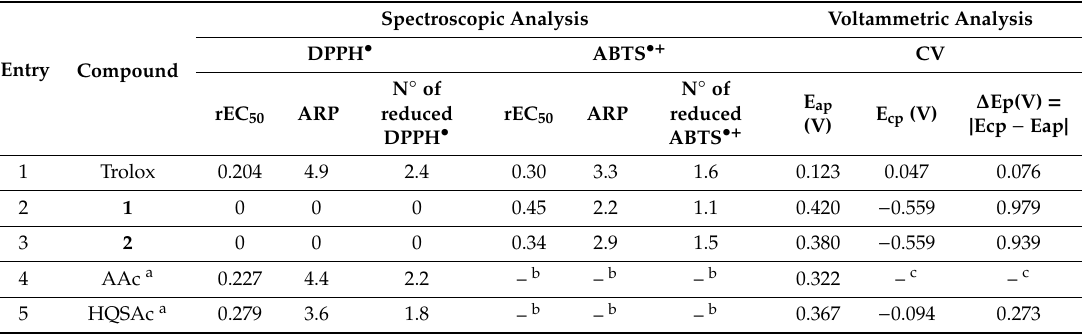
Table 3. Spectroscopic and Voltammetric analysis of di ff erent